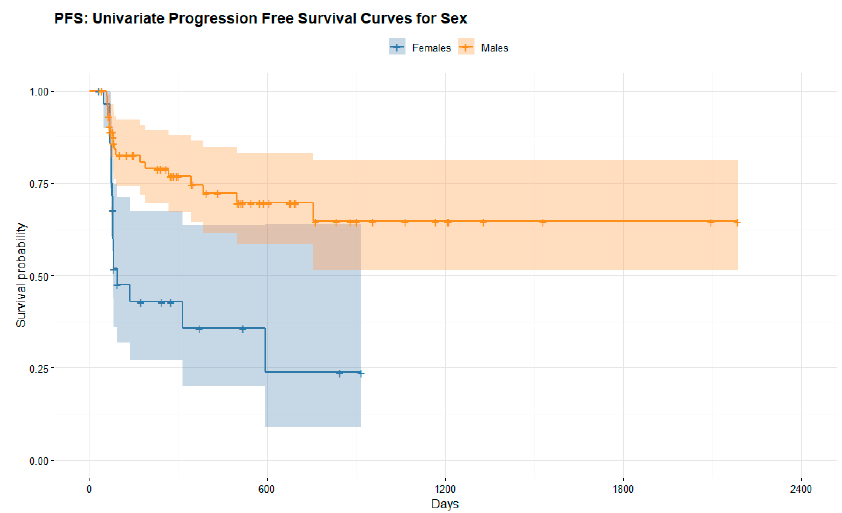
Figure 9. Kaplan–Meier survival curve stratified by progression free survival PFS (in days) in men (orange) and women (blue) with advanced melanoma treated with immunotherapy. The female curve ends earlier than the male curve due to a shorter follow-up time (mean 620 days vs. 880 days for men), as displayed in Figure